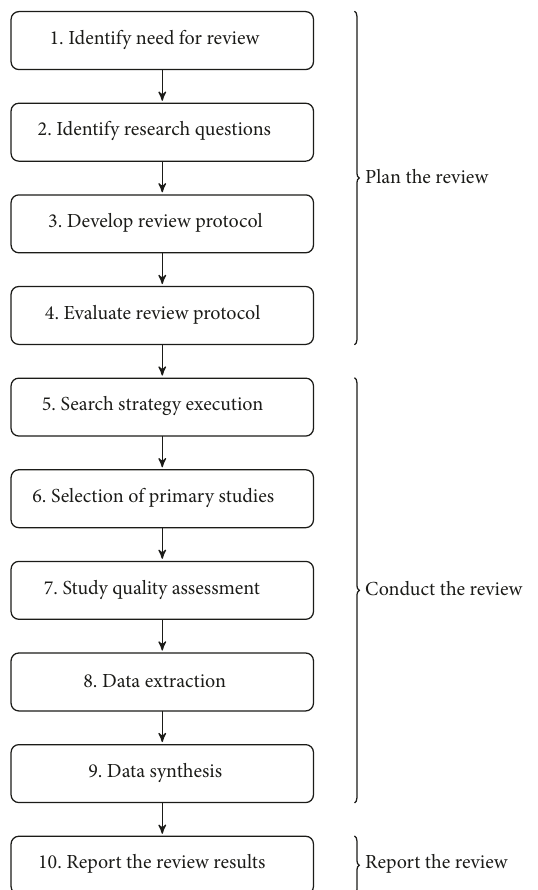
Figure 1: The systematic review process